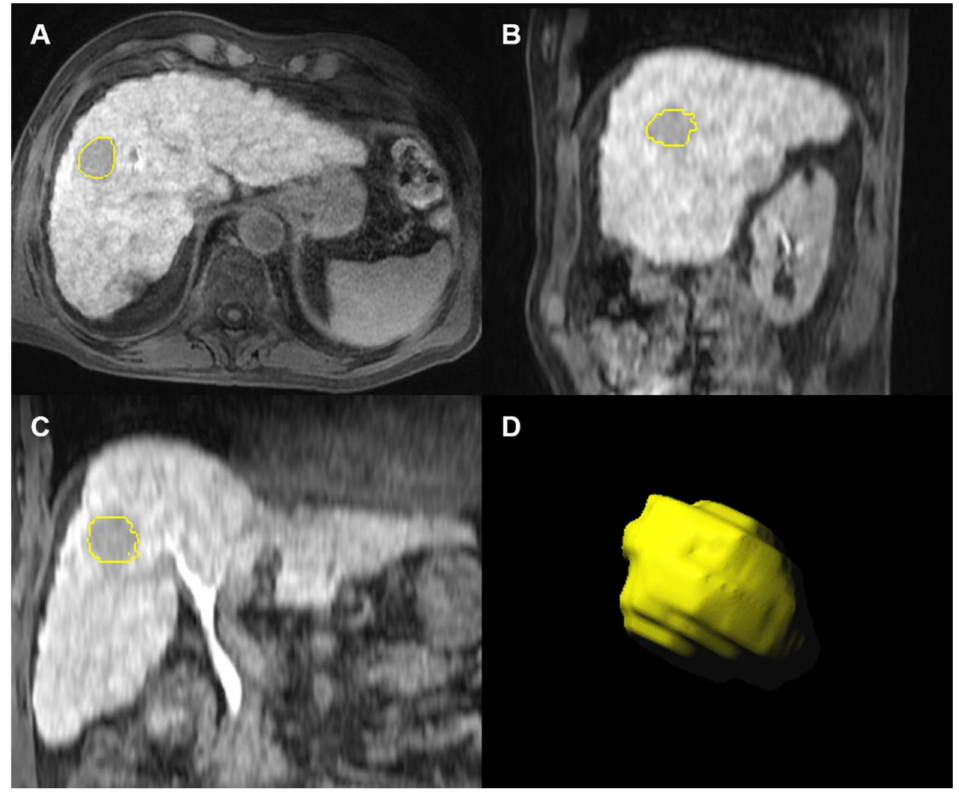
Figure 2. Gadoxetate disodium-enhanced MRI before transarterial embolization in a 74-year-old man with hepatitis C-related cirrhosis and a 27-mm hepatocellular carcinoma. Images shows example of whole tumor segmentation (circles) on axial ( A ), sagittal ( B ), and coronal ( C ) hepatobiliary phase images with volumetric lesion reconstruction ( D